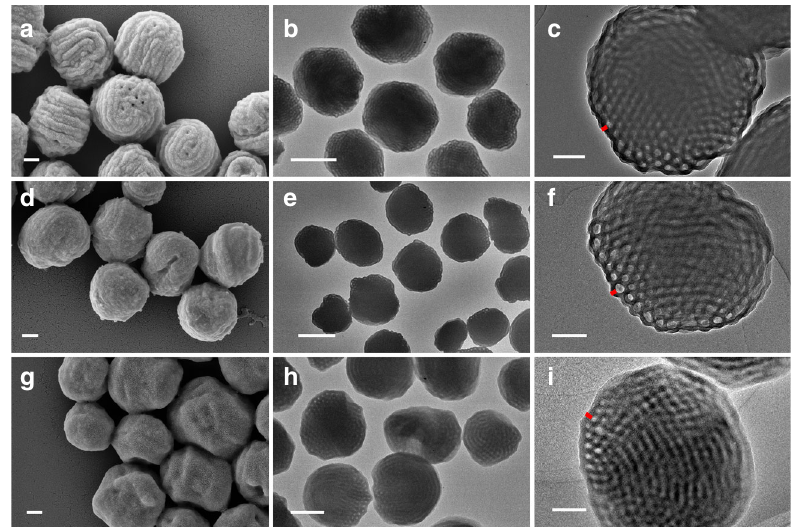
Fig. 4 Scanning electron microscopy (SEM) and transmission electron microscopy (TEM) micrographs of PDMA 29 - b -P(St- alt -PFS) x block copolymer (BCP) particles synthesized in 2% toluene/ethanol at 30% w/v and 70 °C. a – c x = 428 (scale bars: 200 nm, 500 nm and 200 nm), d – f x = 490 (scale